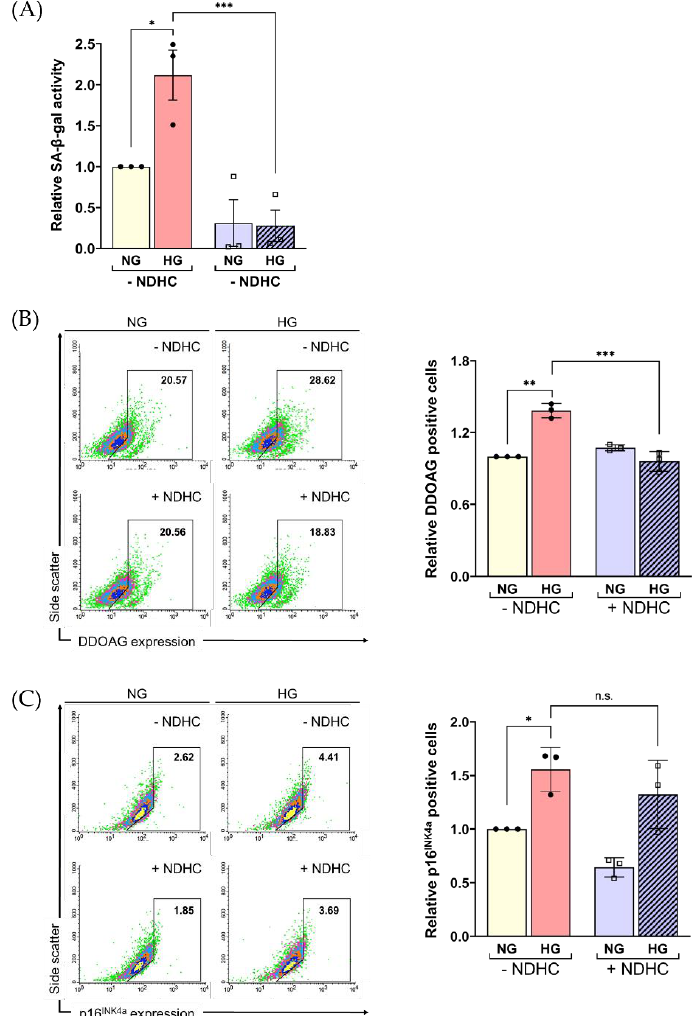
Figure 5. Effect of NDHC pretreatment on the senescence in HLE under high-glucose conditions. ( A ) Senescence-associated β -galactosidase (SA- β -gal) activity in HLE cells either pretreated with or without 10 µ M of NDHC before exposure to 5.5 mM (NG) or 55.5 mM (HG) glucose was assessed for 5 days. ( B , C ) Flow cytometry was used to evaluate senescence-associated phenotypic changes. Cells were treated as in ( A ), and the percentage of DDAOG-positive and p16-positive cells was analyzed and is shown in the graphs as the mean ± SD. Data are representative of 3 independent experiments (mean ± SD). * p < 0.05, ** p < 0.01, *** p < 0.001, n.s. = not